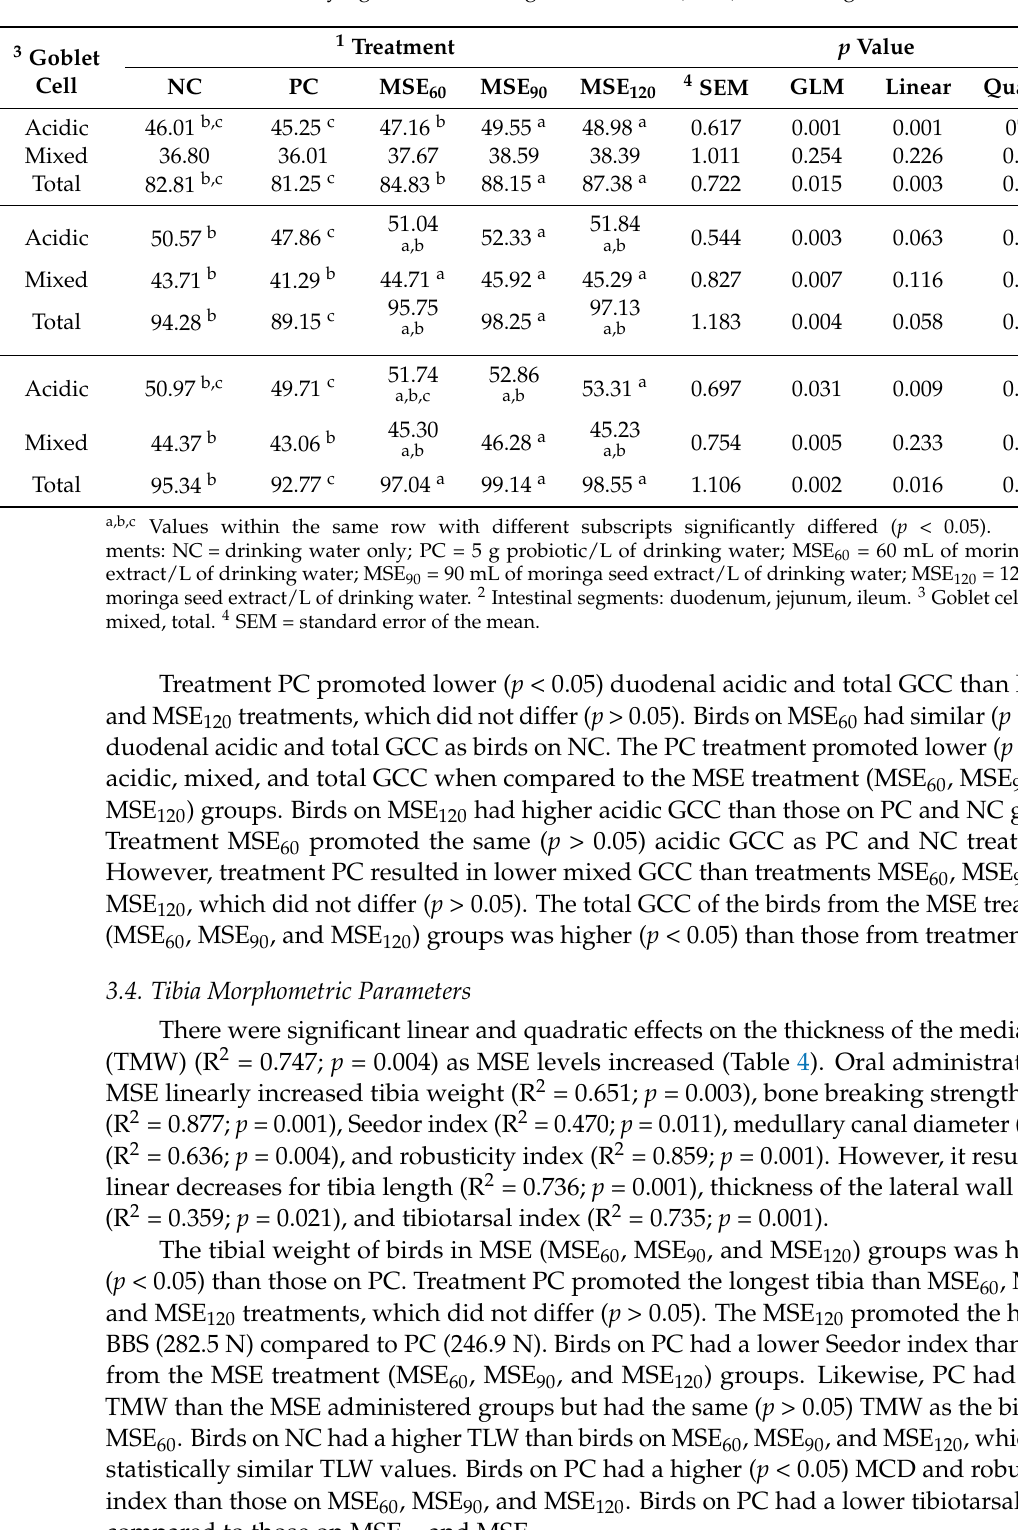
Table 3. Goblet cell count (per 100 µ m villus height) of six-week-old broiler chickens ( n = 125) orally administered with varying levels of moringa seed extract (MSE) in drinking